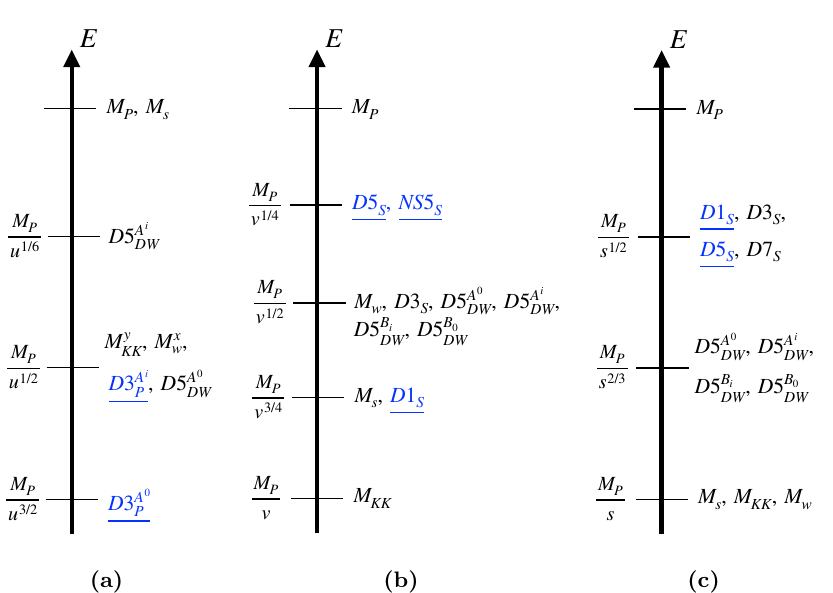
Figure 5. Energy scales associated to the 4d particles, strings and domain walls that become massless/tensionless at the in(cid:12)nite distance points given by (a) u ! 1 , s , v (cid:12)xed, (b) v ! 1 , s , u (cid:12)xed, and (c) s / v ! 1 , u (cid:12)xed. The string, KK and winding scales are also indicated. These are the T-duals of (cid:12)gure 3. Objects in blue and underlined are projected out in the orientifold. isotropic situation with v = v = v = v , and u 1 = u 2 = u 3 = u . The energy scales of 1 2 3 strings and domain walls are estimated by a suitable root of their tensions. In (cid:12)gure 5 we depict the energy scales in three di(cid:11)erent limits. Notice that in the limit of large complex structure, u ! 1 , at the same scale there are tensionless domain walls and massless par- ticles, both belonging to in(cid:12)nite towers. Thus, it would be important to take into